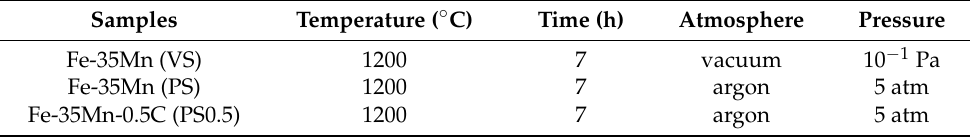
Figure 1. SEM morphology of ( a ) the pre-alloyed Fe-35Mn powder and ( b ) graphite powder; ( c ) injection green parts and sintered parts of the tensile samples. Table 1. The main sintering parameters of the VS, PS, and PS0.5 alloys.